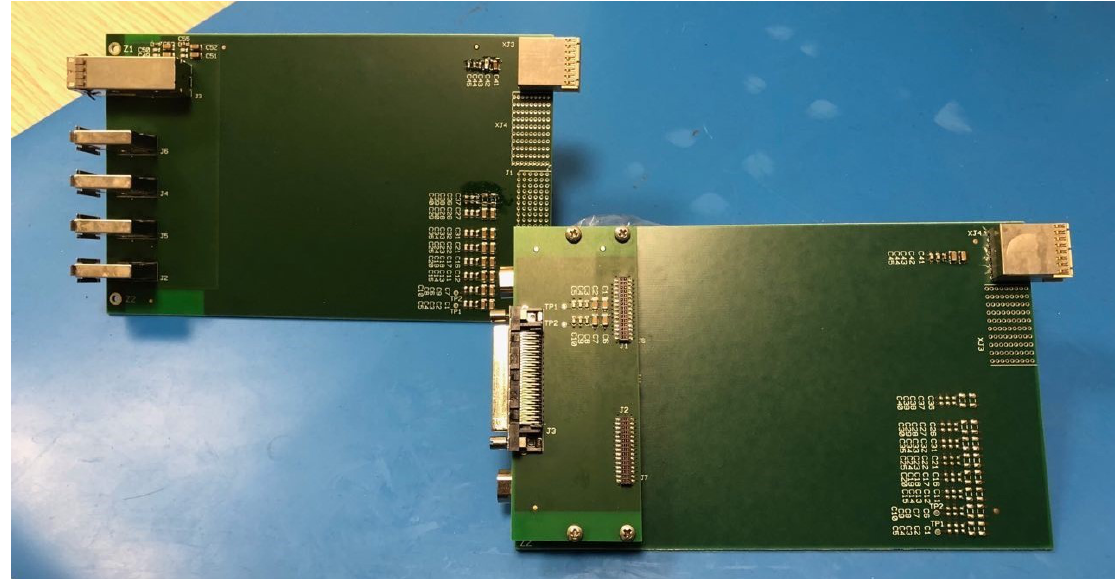
Figure 4. Picture of the adapters for the SpaceFibre and SpaceWire compliant